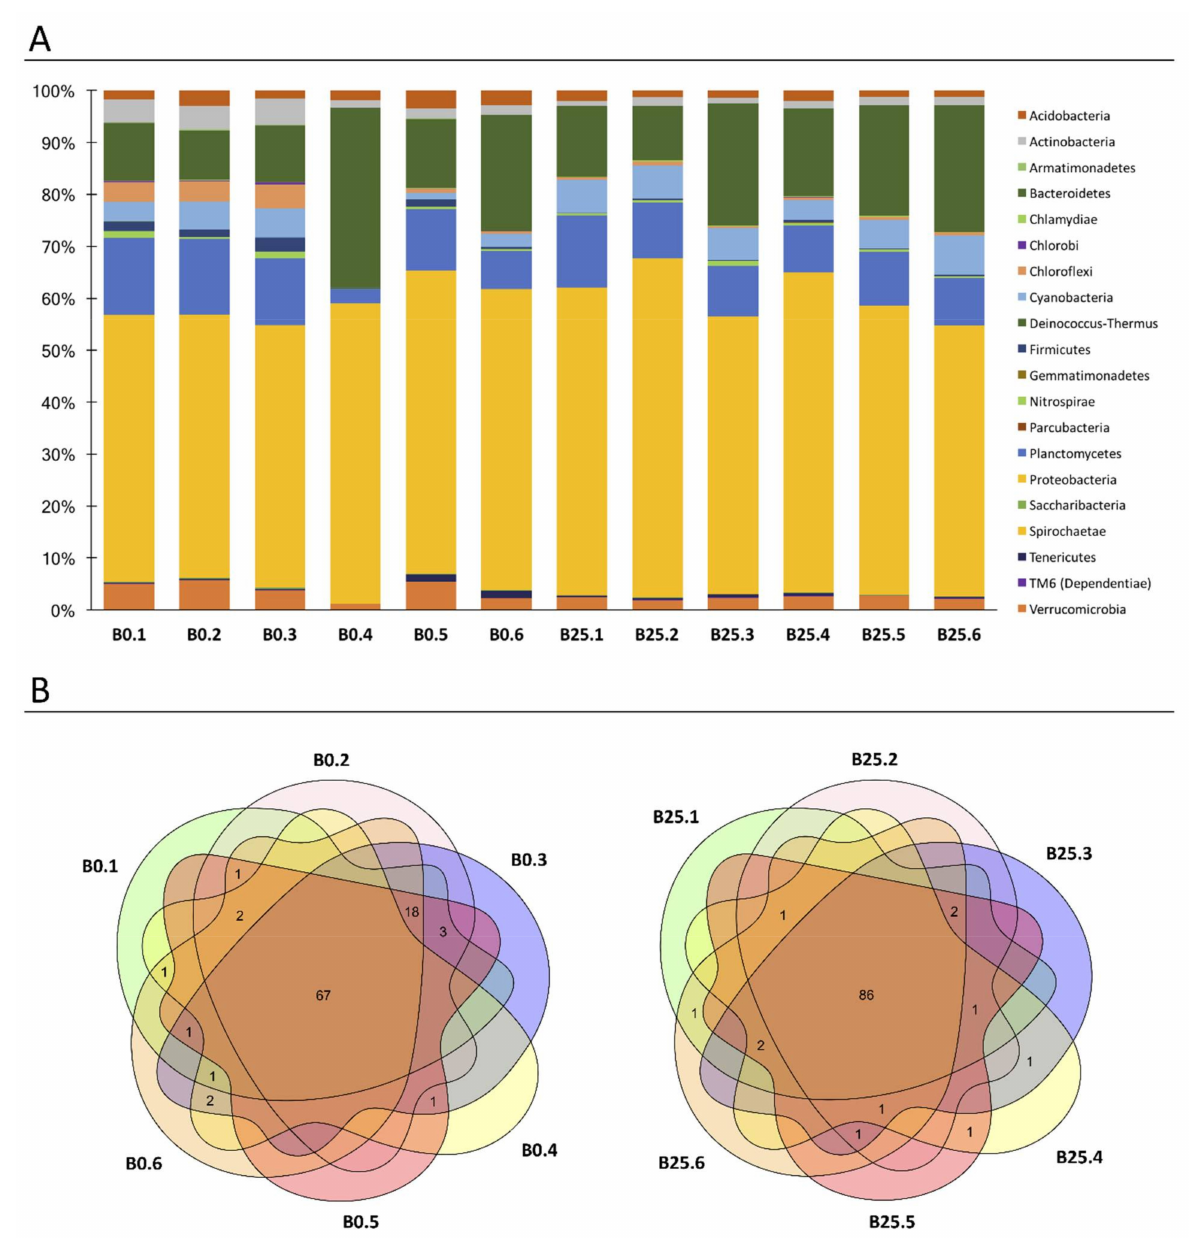
Figure 2. Biomphalaria glabrata microbiota characterization: Biomphalaria bacterial microbiota of six naive snails recovered at the starting of the experimentation (B0.1; B0.2; B0.3; B0.4; B0.5 and B0.6) and 6 naive snails recovered 25 days after the starting of the experimentation (B25.1; B25.2; B25.3; B25.4; B25.5 and B25.6) were analysed. ( A ). Phylum level composition of the 20 most abundant OTUs phyla among the 12 naive snails. ( B ). The Venn diagram represents the number of the 97 OTUs families, which shared between the 6 naive snails at B0 (left Venn diagram), and between the 6 naive snails at B25 (right Venn